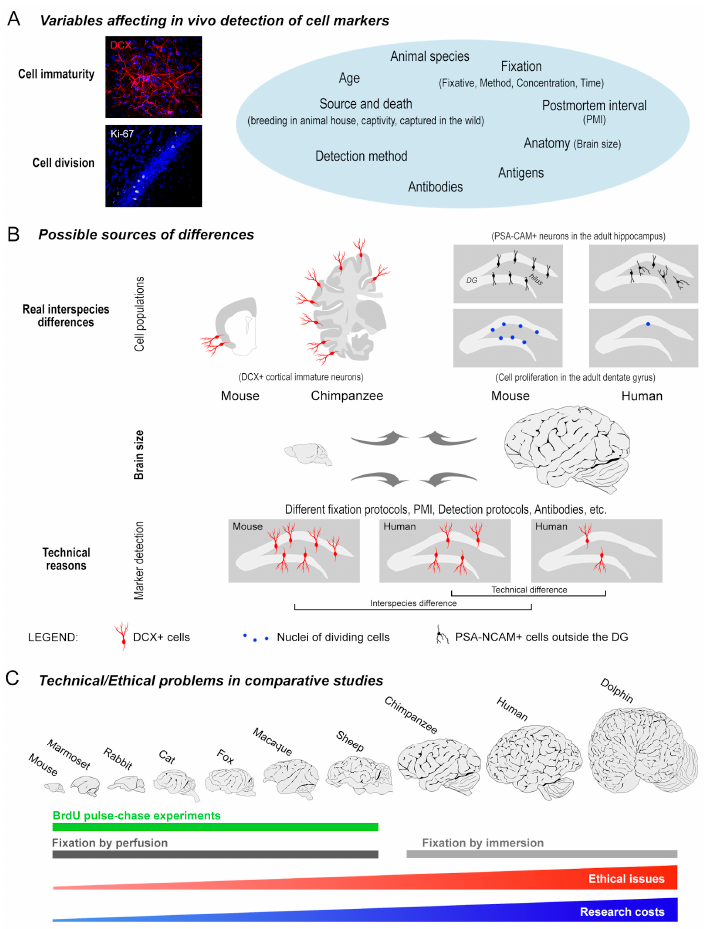
Figure 1. The complex landscape of cell marker detection in comparative neuroplasticity. ( A ) The two most used markers for in vivo detection of neuronal immaturity (doublecortin, DCX) and cell division (Ki67 antigen), and the main variables affecting their detection in the brain tissue; Image magnification: 40 × . ( B ) The possible sources of variation can depend on several reasons, including differences linked to the animal species (neuroanatomy, evolutionary choices in the types of neuroplasticity, and intrinsic differences in the expression of cells/markers), and/or technical reasons linked to the procedures of brain sampling and fixation, potentially varying in relation to brain size. ( C ) Difficulties encountered in cell marker detection increase with increasing brain size and complexity of cognitive abilities (from mice to humans) on the basis of technical and ethical